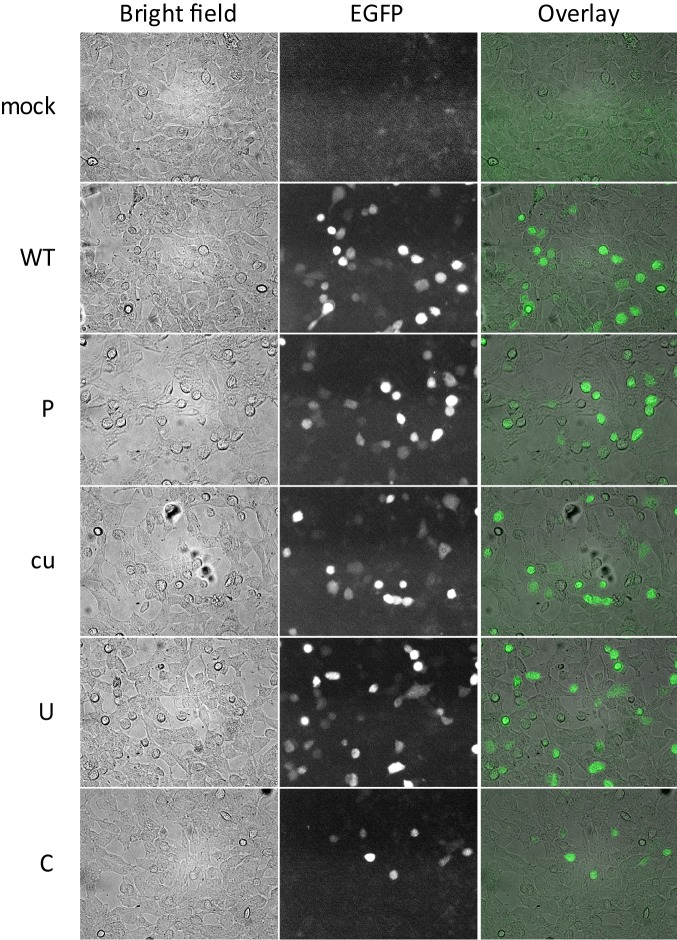
Protein expression from E7 replicons with ncR1 compositional variants.RD cells transfected with E7_EGFP replicons with 3’ ncR1 variants together with E7luc replicon containing a 3’ ncR1 tail of WT composition. EGFP replication was imaged at 6 hpt with identical exposure times.